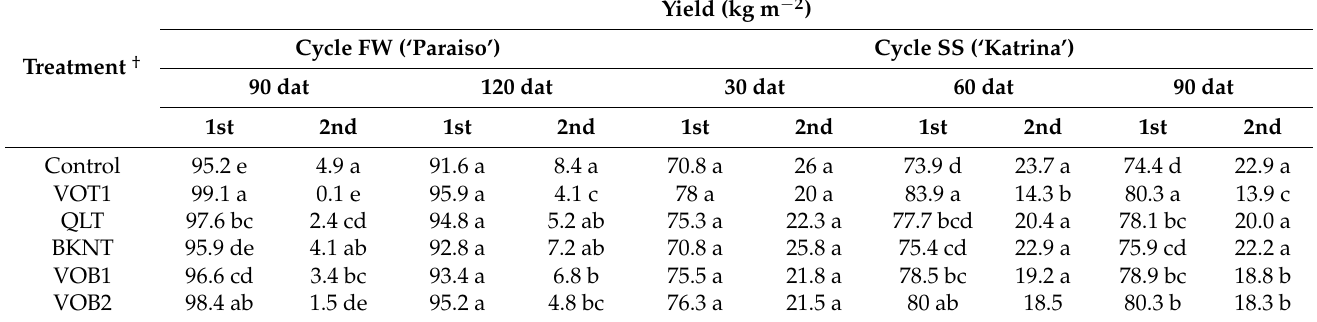
Table 9. Effect of the treatments on the first (‘Premium’) and second quality cucumber fruits during the FW and SS